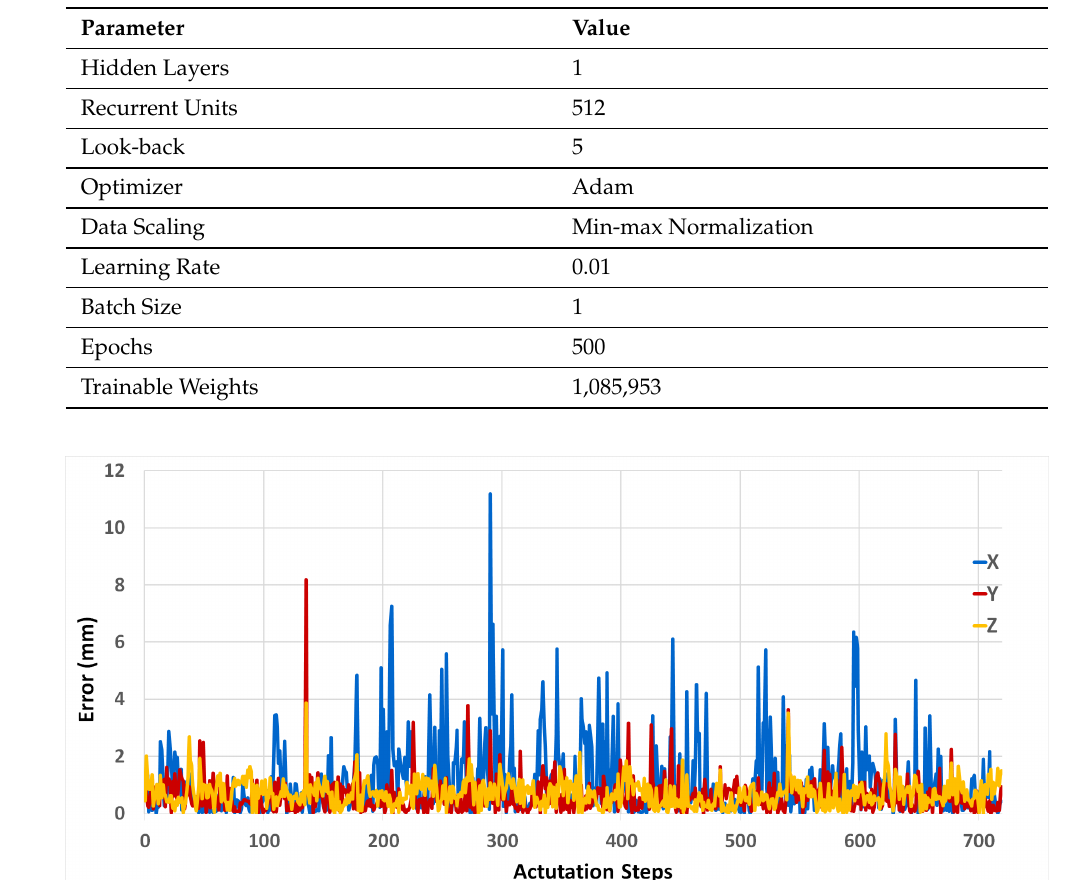
Table 2. LSTM network parameters.